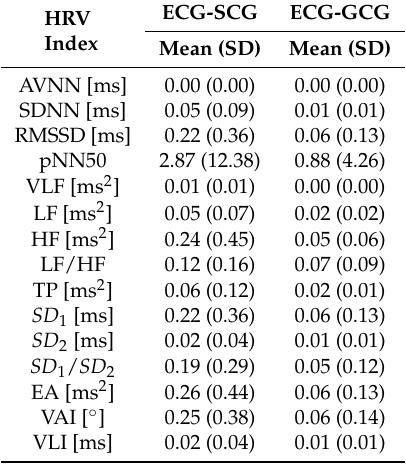
Table 4. Mean and standard deviation of relative error of HRV indices calculated on full